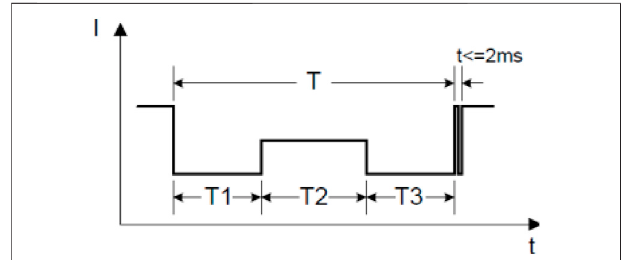
FIGURE 9 | Switching sequence diagram of